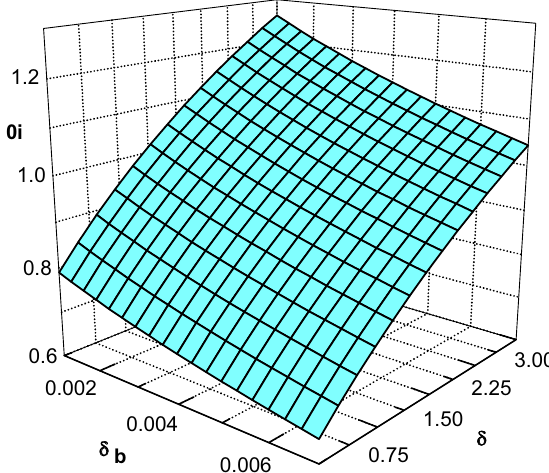
Figure 4. Ion velocities at the sheath edge as a function of δ and δ b for φ 0 = 0.008 , σ h = 10 , σ i = 0.02 , m = 1 / 1836 , κ c = 2.4 and κ h = 4 .